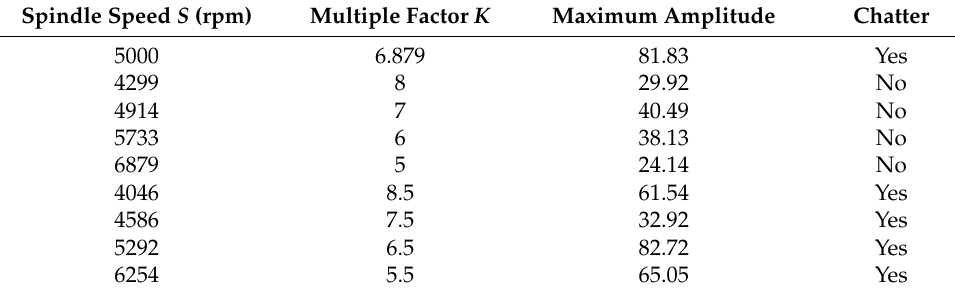
Table 5. Results of the chatter suppression tests.